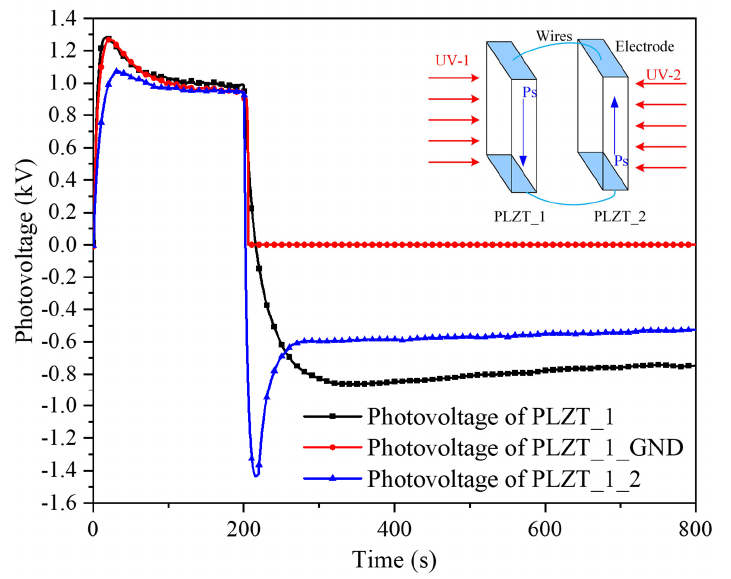
Figure 22. Photovoltage of PLZT_1, PLZT_1_GND and PLZT_1_2 under irradiation of 300 mW/cm 2